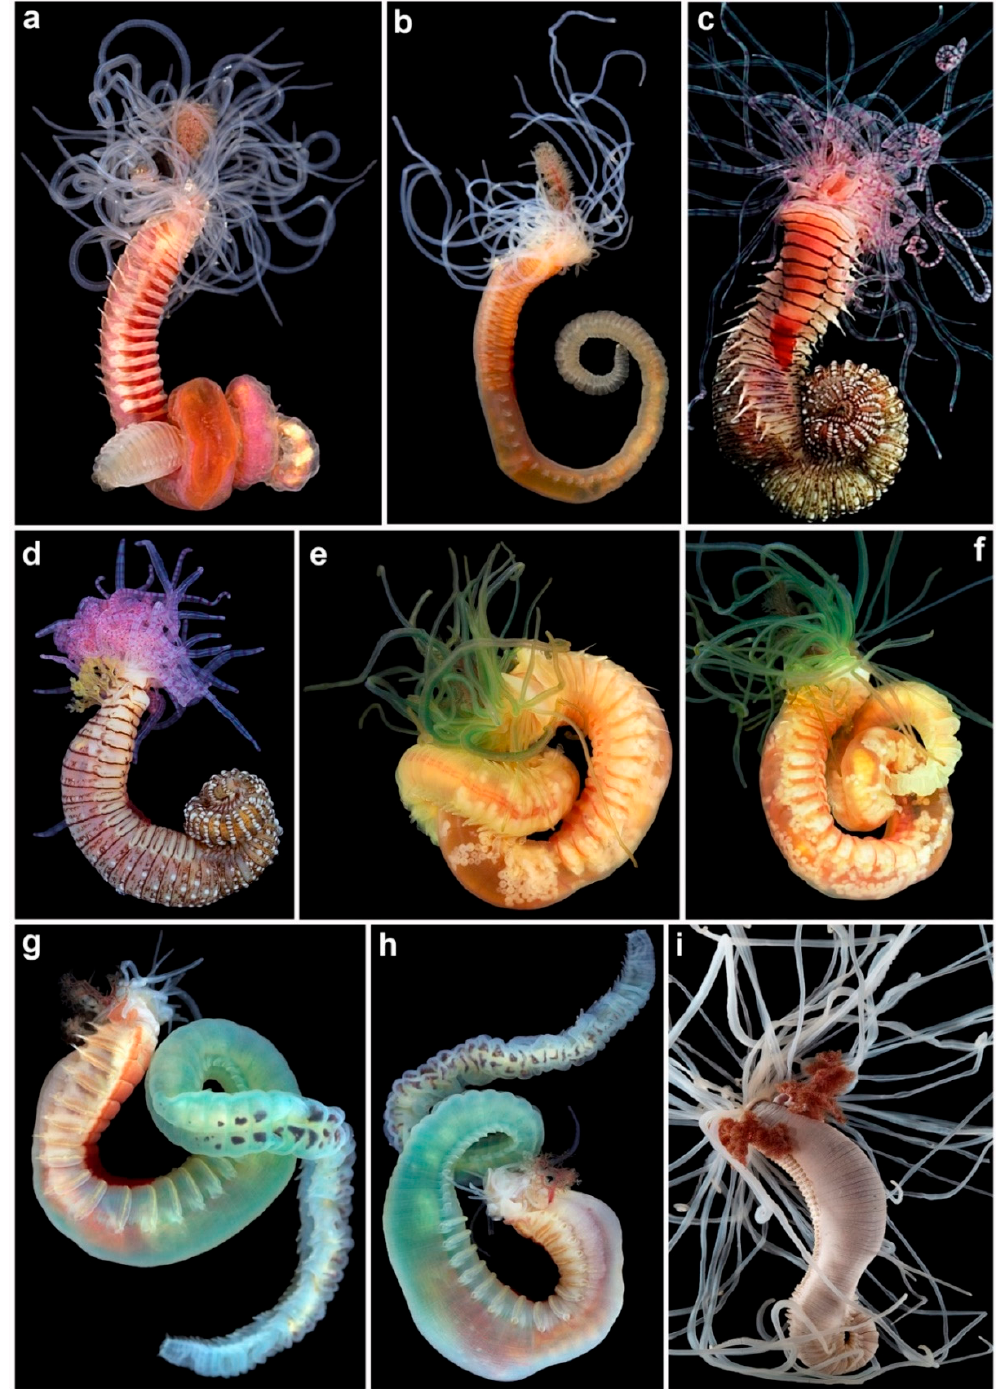
Figure 3. ( a , b ) Diversity of Terebelliformia: Terebellidae s.l. (TER) Pistella franciscana : complete live worm, right lateral views; ( c , d ) Loimia tuberculata (holotype AM W.44280): complete live worm, ventral and right lateral views, respectively; ( e , f ) Pista chloroplokamia (holotype AM W.44613): entire live worm, female, left and right lateral views; ( g , h ) Loimia pseudotriloba (holotype AM W.47810): entire live worm, right and left lateral views; ( i ) Reteterebella lirrf (paratype AM W.44545): entire live worm, dorso-lateral view. All animals removed from their tubes. Photos: ( a – i )—A. Semenov.